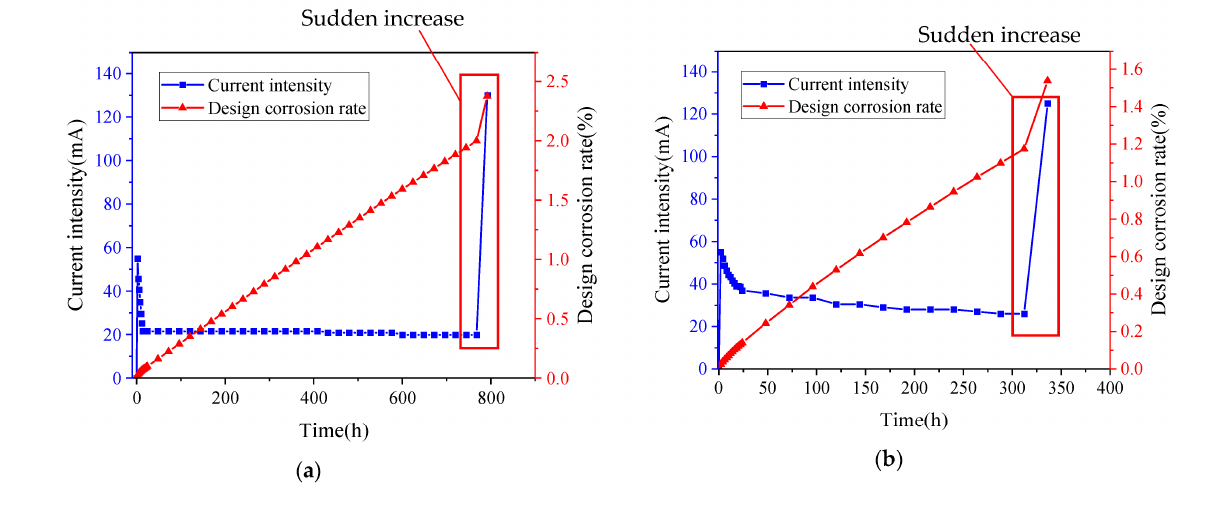
Figure 5. Relationship between the current intensity and designed corrosion degree: ( a ) ASC and ( b ) OPC. Table 5. Designed and measured values of steel bar corrosion degree in